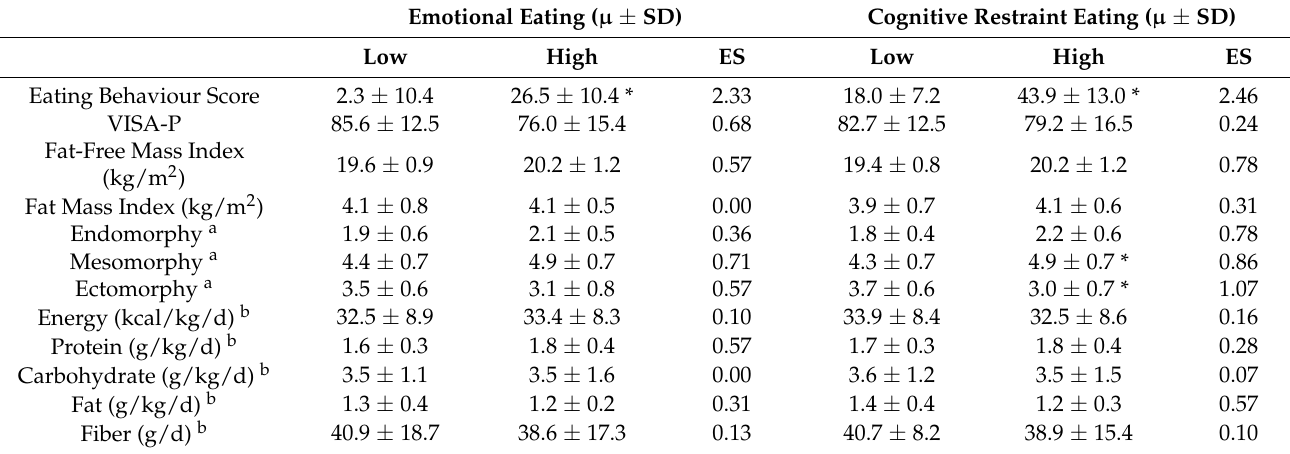
Table 6. Difference in physique trait, knee health and nutrient intake between low and high eating behaviours ( n =